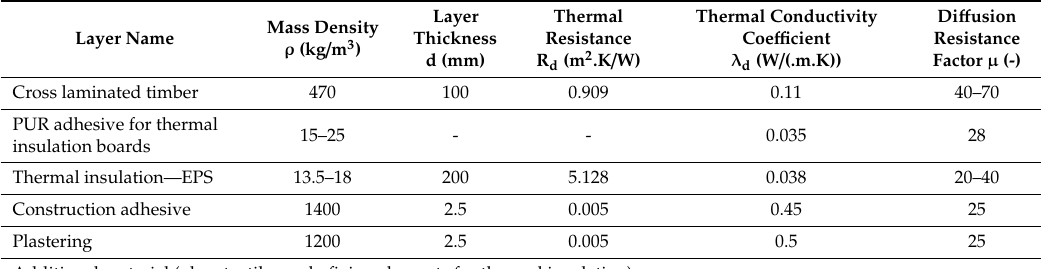
Table 1. Structure of layers from the interior to the exterior—variant